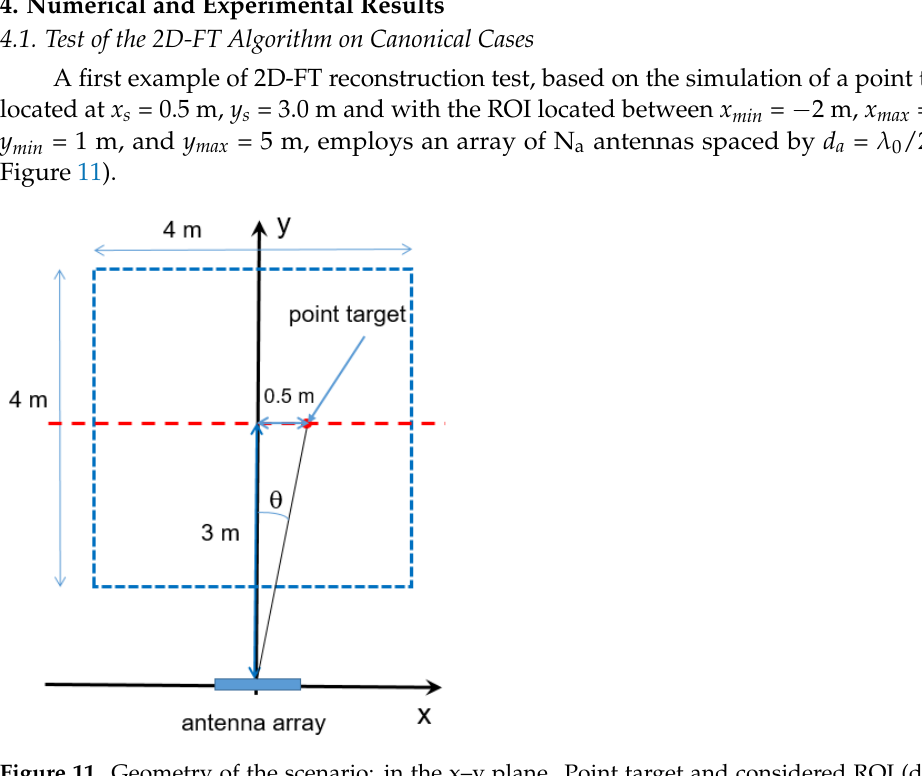
Figure 10. Prototype of the realized modular radar.